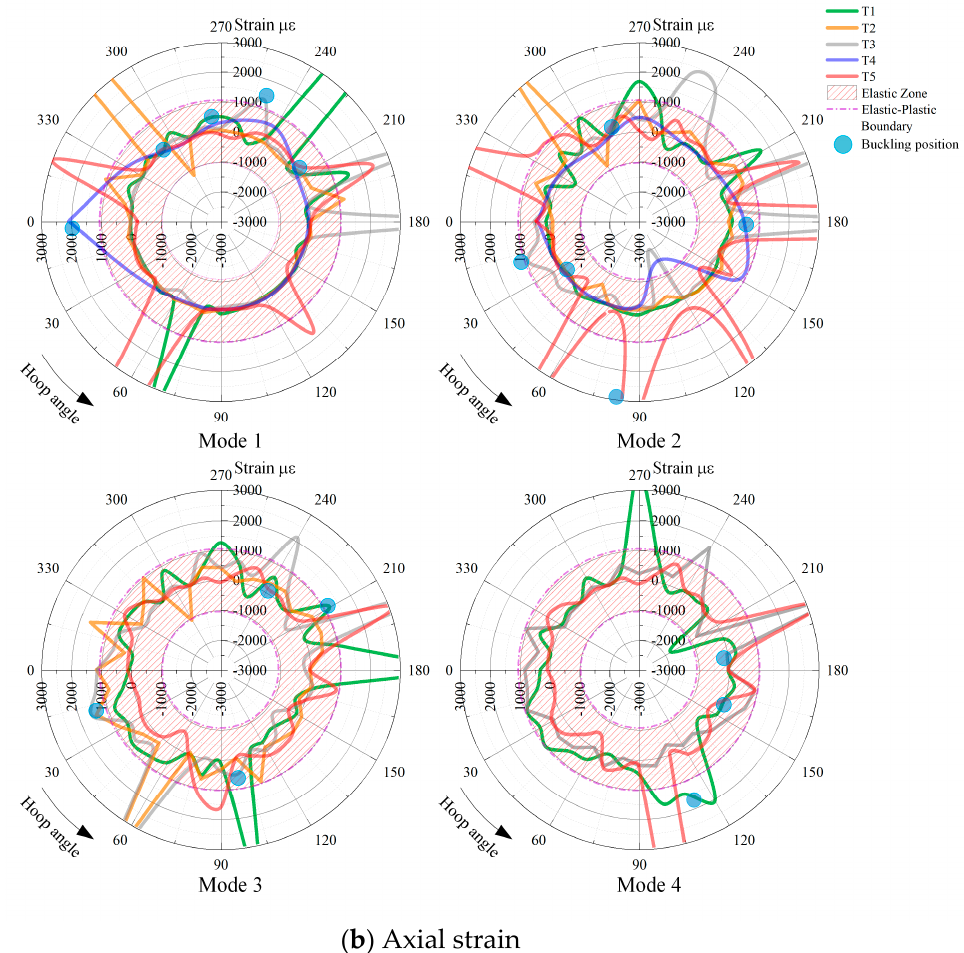
Figure 10. SSL strain in different buckling modes.